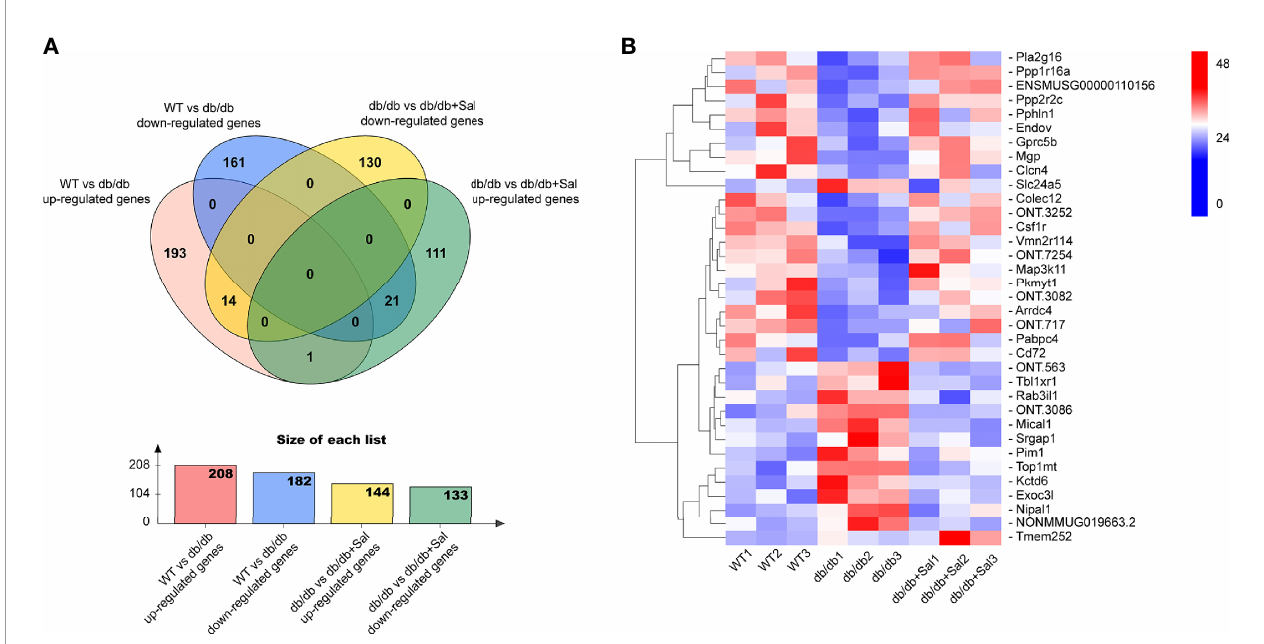
FIGURE 5 | Sal ameliorates retinal transcriptome abnormalities in db/db mice. (A) The Venn diagram showing the differentially expressed genes (DEGs) among WT mice, db/db mice and Sal-treated db/db mice. (B) The heat map showing the Sal-restored DEGs (35 genes) and Sal-aggravated DEGs (1 gene) between WT and db/db